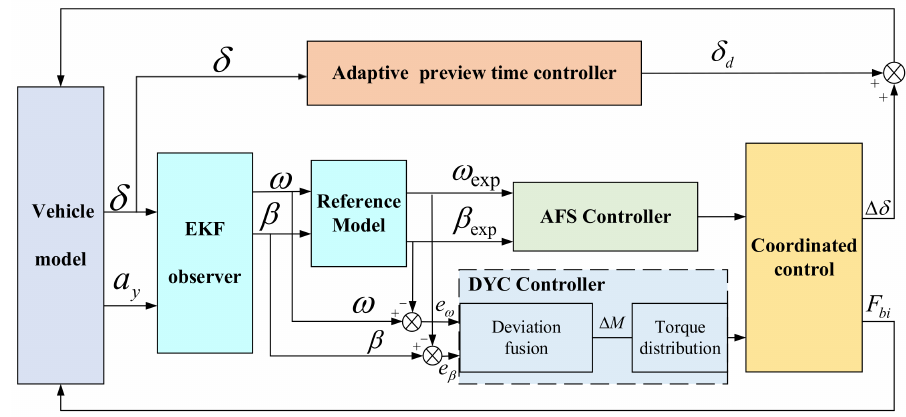
Figure 9. The overall architecture of the coordinated